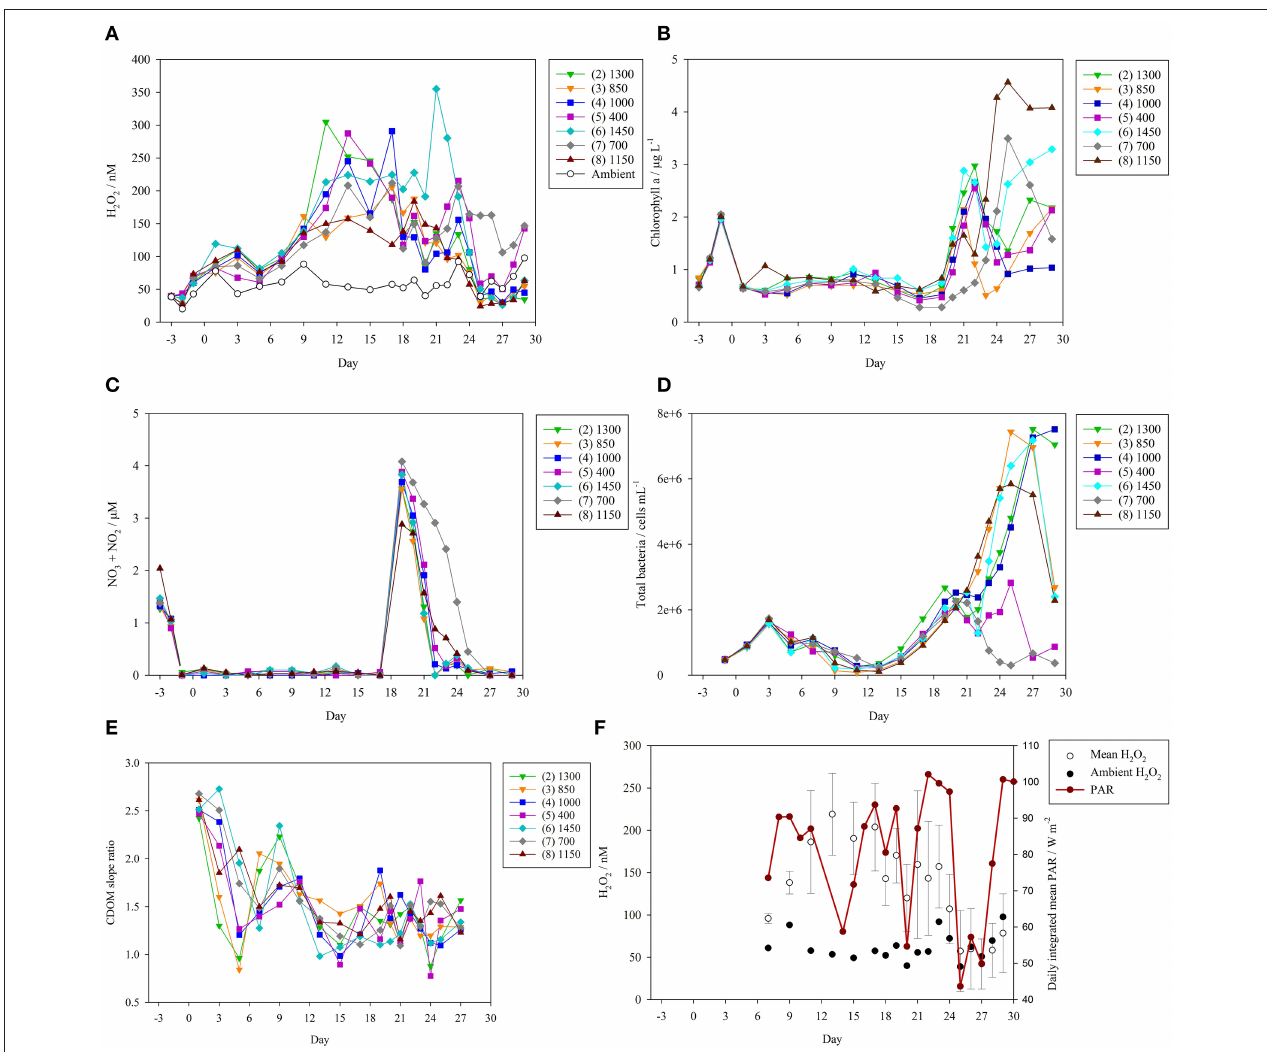
FIGURE 1 | Time series of core parameters over the experiment duration. The eight mesocosms (numbered 1–8) were subject to a pCO 2 gradient (400–1,450 µ atm) imposed by the addition of CO 2 saturated, filtered seawater on day 0 (5 March 2016). Labels refer to target pCO 2 levels ( µ atm) which were obtained on pCO 2 addition days (see Supplementary Figure 1 ). The 550 µ atm pCO 2 mesocosm (1) was discontinued after day 3 due to leakage and exchange with outside seawater and so no data is shown. (A) H 2 O 2 concentrations (nM) during the mesocosm experiment. H 2 O 2 concentration was also measured in ambient surface seawater outside the mesocosms (open circles). (B) Chlorophyll a concentrations ( µ g L − 1 , depth integrated samples) throughout the experiment. (C) Nitrate + nitrite concentrations ( µ M, depth integrated samples) throughout the experiment. One macronutrient addition (3.1 µ M nitrate, 1.5 µ M silicate, and 0.2 µ M phosphate) was made on day 18 to stimulate a phytoplankton bloom. (D) Total bacteria (cells mL − 1 ) during the mesocosm experiment. (E) Chromophoric dissolved organic matter (CDOM) slope ratio ( S R ), a dimensionless parameter that is inversely proportional to molecular weight. (F) Photosynthetically active radiation (PAR, mean irradiance integrated over each experiment day, W m − 2 ), available only for experiment day 7 onwards, compared to ambient seawater and mean ( ± standard deviation) mesocosm H 2 O 2